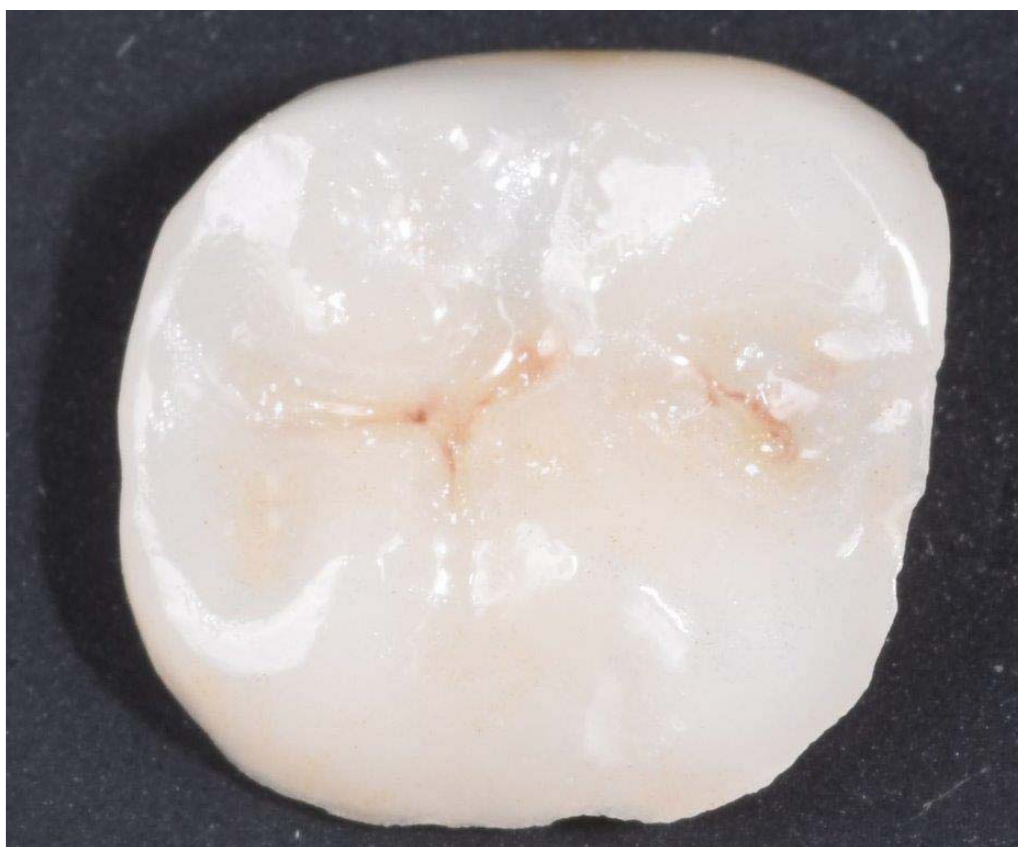
Figure 4. The prepared overlay restoration before cementation.